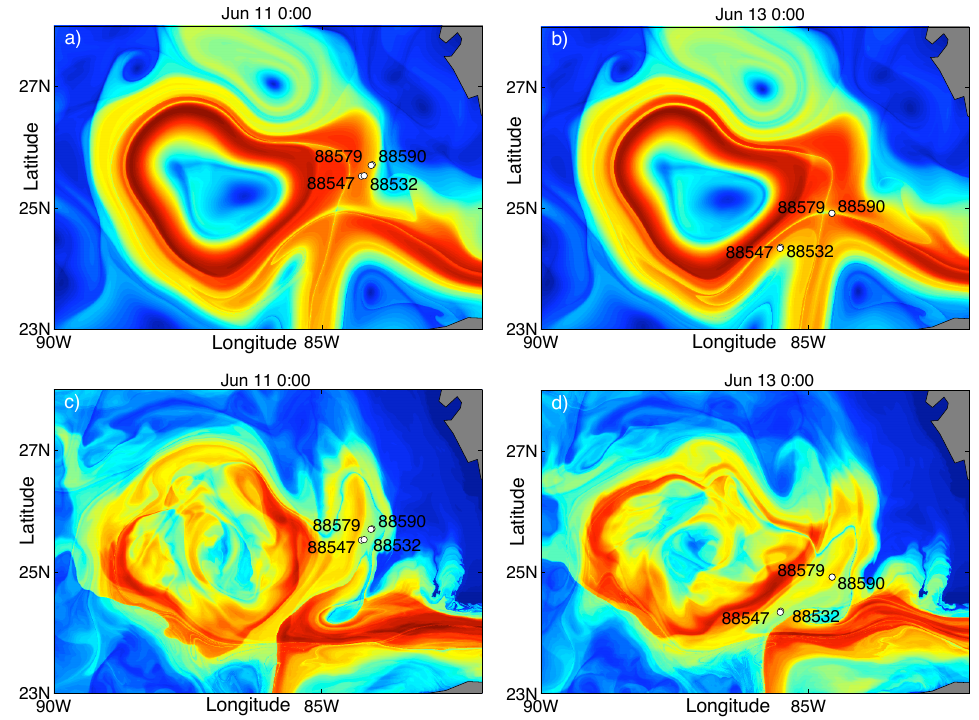
Figure 6. Sequence that shows the evolution of the Lagrangian structures with AVISO – (a) and (b) – and HYCOM – (c) and (d) – data. Fig. 6. Sequence that shows the evolution of the Lagrangian structures with AVISO –a) and b)– and HYCOM –c) and d)– data. Drifters “88532”, “88547”, “88590”, and “88579” are overlapped with these structures. The left column displays results for 11 June and the Drifters ’88532’, ’88547’, ’88590’, ’88579’ are overlapped with these structures. The left column displays results for the 11th June right one for 13 and the right one for the 13th of June.